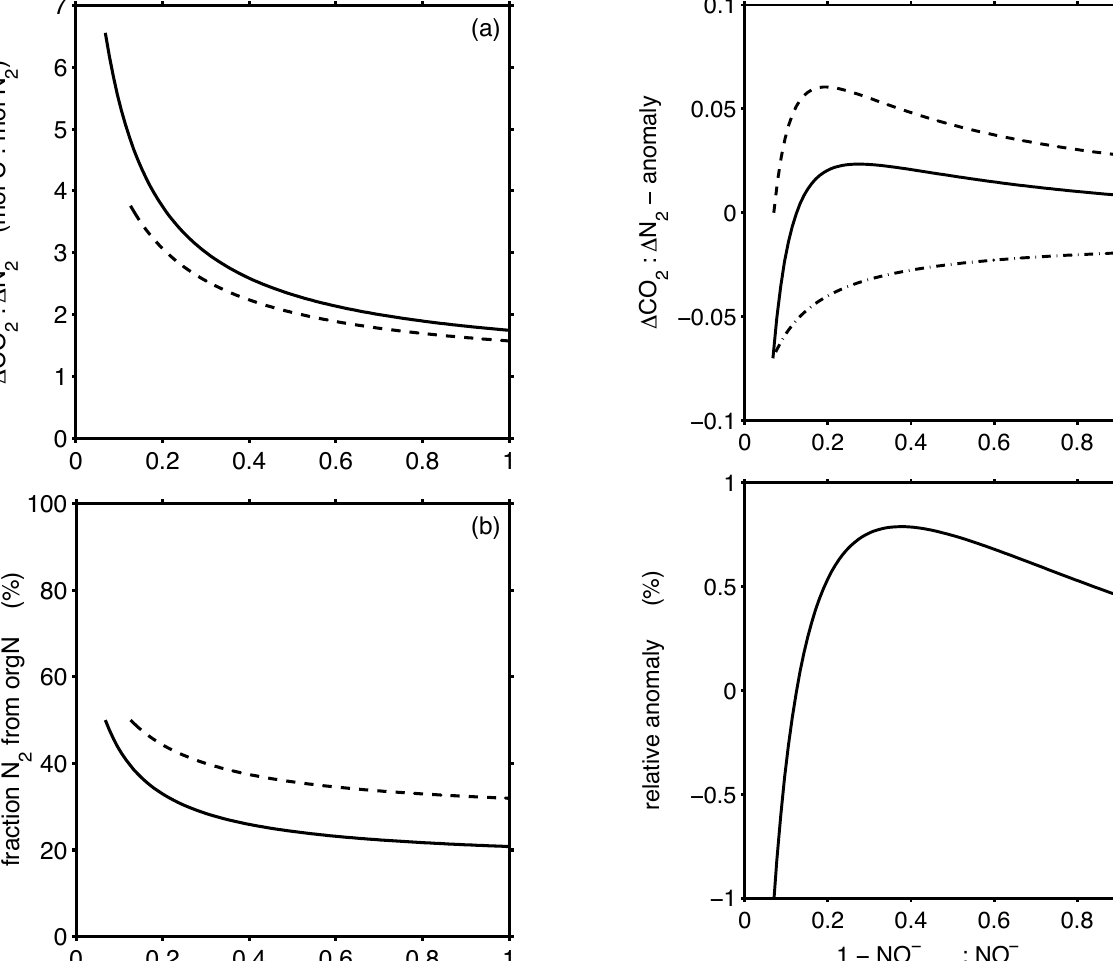
Fig. 3. Effects of autotrophic CO 2 fixation on 1 CO 2 : 1 N 2 ratio (for scenario I). (a) Absolute anomalies (mol:mol). Dash-dotted line shows the direct effect of CO 2 fixation on 1 CO 2 : 1 N 2 as difference between 1 CO 2 : 1 N 2 (corrected for CO 2 -fixation) and 1 CO 2 : 1 N 2 (without this correction). Dashed line shows the indi- rect effect from NO − production during anammox on 1 CO 2 : 1 N 2 3 as difference between 1 CO 2 : 1 N 2 (corrected for NO − -production) 3 and 1 CO 2 : 1 N 2 (without this correction). This indirect effect acts on values of the x-axes, not the 1 CO 2 : 1 N 2 itself. The solid line gives the combination of both effects. (b) Plot shows the relative anomaly (%), i.e. the combined anomaly due to CO 2 - fixation and NO − -production from (a) devided by the fully cor- 3 rected 1 CO 2 : 1 N 2 ratio times